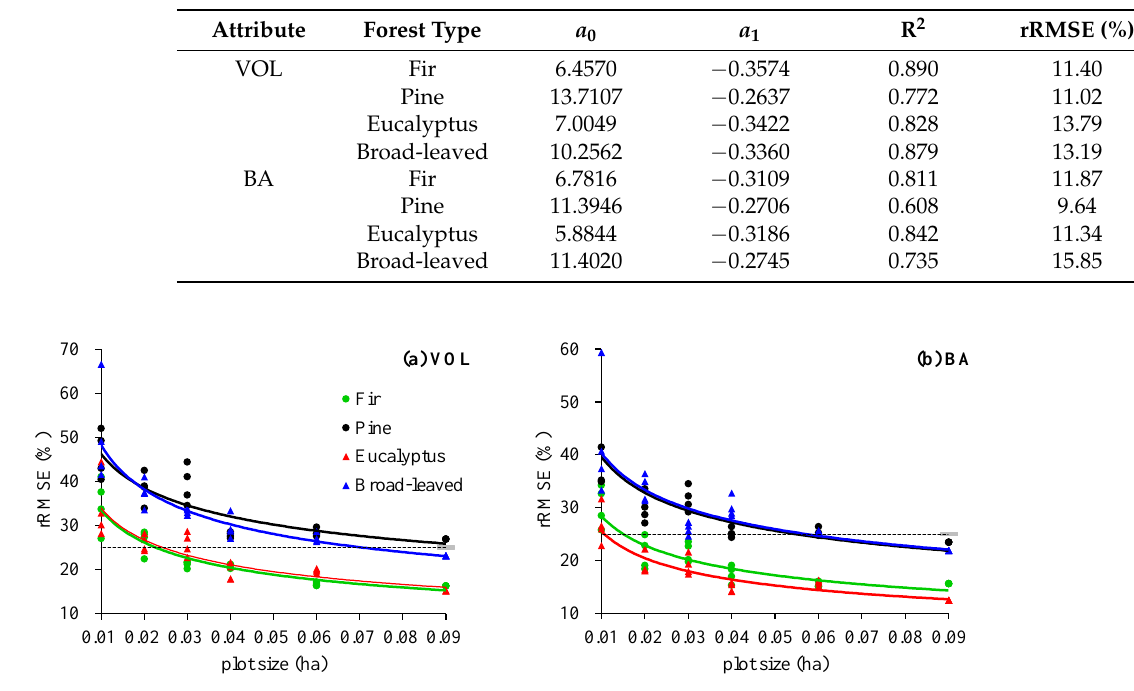
Figure 5. Regression relationships between the rRMSE of the VOL ( a ) and BA ( b ) estimation models and plot sizes (ha) for four forest types. Table 6. Theoretical difference (%) of rRMSEs between plots of different sizes and the 900 m 2 plots calculated from the rRMSE plot size regression models in VOL and BA estimation in four forest types.